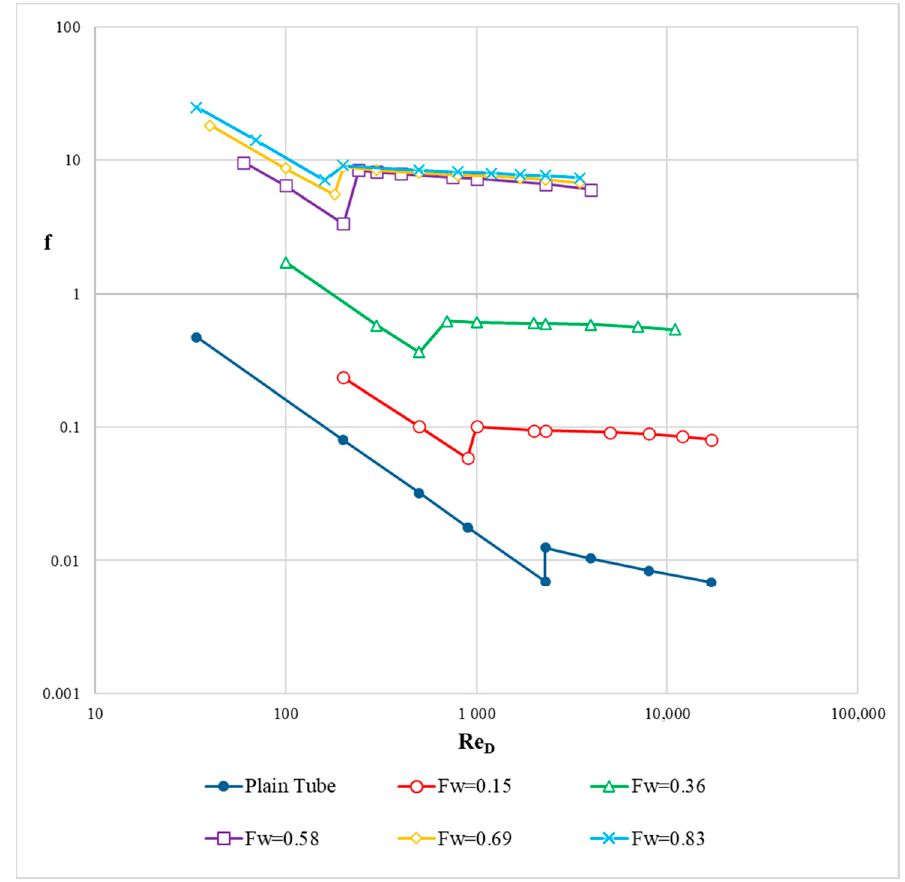
Figure 8. Simulated results of the friction factor for plain and wavy-walled tubes.